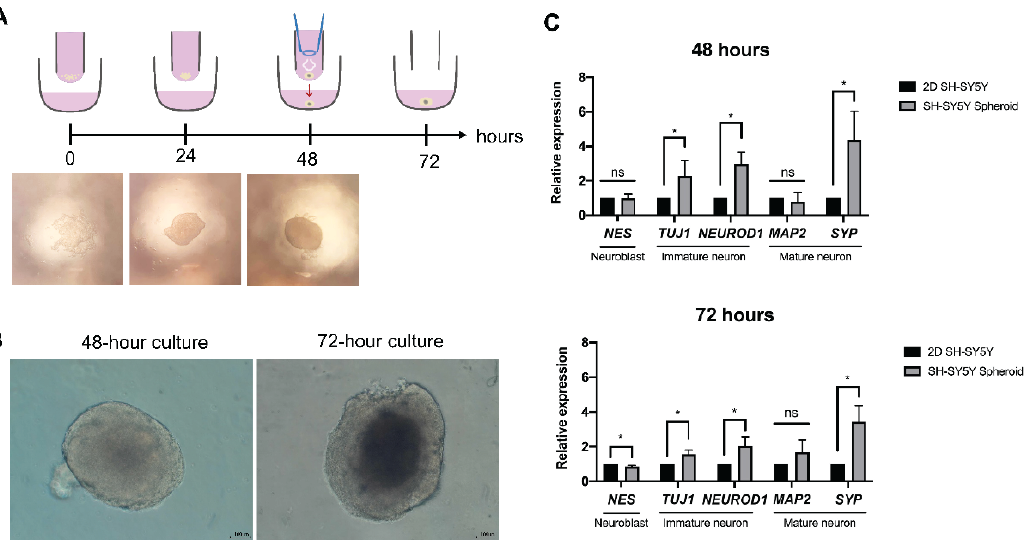
Figure 1. Neurospheroid formation in a hanging drop culture. ( A ) Schematic diagram of spheroid formation in a hanging drop of the culture medium. Images of cell aggregates were visualized using a stereomicroscope. Microscopic images were captured using 4 × magnification on a stereomicroscope. ( B ) Spherical shape of the cell aggregate observed under an inverted microscope. Scale bar, 100 µ m. ( C ) Relative levels of neuron-specific transcripts in the 3D SH-SY5Y neurospheroid and the 2D cultured SH-SY5Y cells. The data are representative of independent experiments ( n = 3). Quan-